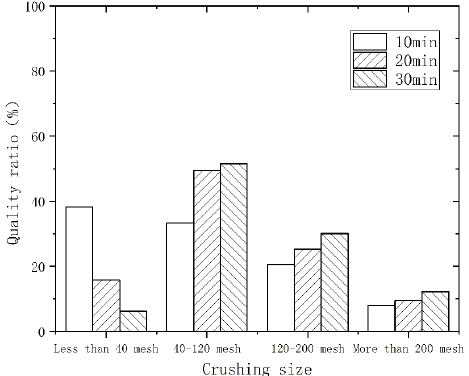
Figure 3. Particle size distribution for different times at 4000 r/min.